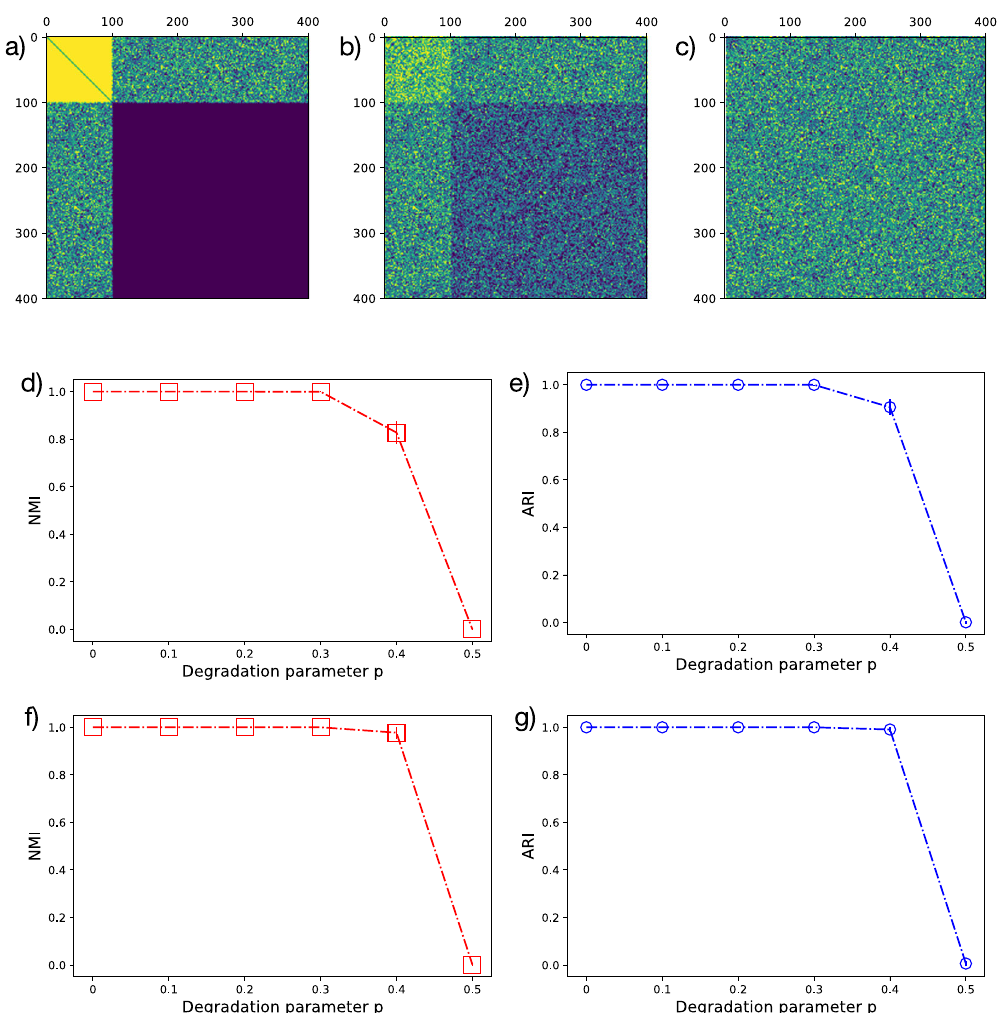
Fig. 6 Benchmark for testing surprise on recovering core-periphery structures. The benchmark de fi ned here progressively ‘ degrades ’ the initial con fi guration represented in panel a and de fi ned by (1) a completely connected core, (2) an empty periphery, (3) an intermediate part whose link density amounts at p cp = 0.5. Such a con fi guration is ‘ degraded' by progressively fi lling the periphery and emptying the core. This is achieved by (1) considering all peripherical node pairs and link them with probability q p ; (2) considering all core node pairs and keep them linked with probability 1 − q c : varying q p in the interval [0, p cp ] and q c in the interval [0, 1 − p cp ] allows us to span a range of con fi gurations starting with the Borgatti-Everett one and ending with an Erdös-Renyi one. Panels b and c represent two con fi gurations for which q c = q p = 0.3 and q c = q p = 0.5. In panels d and e we show the evolution of the Normalized Mutual information (NMI) and of the Adjusted Rand Index (ARI) as a function of the degradation parameter q c = q p , for the partitions recovered by surprise on undirected benchmarks; analogously, in panels f and g , for the directed benchmarks. As expected, the performance of the surprise worsens as q c = q p ≃ p cp = 0.5; however, both the NMI and the ARI steadily remain very close to